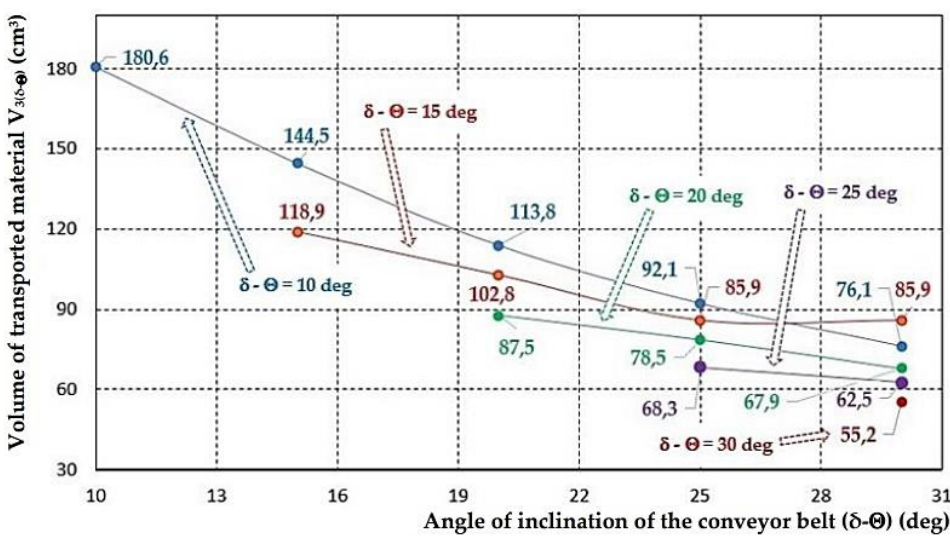
Figure 9. Batch volume V 3( δ–Θ ) material, spread on the conveyor belt, retained by a belt cleat with a height of H 1 = 20 mm.